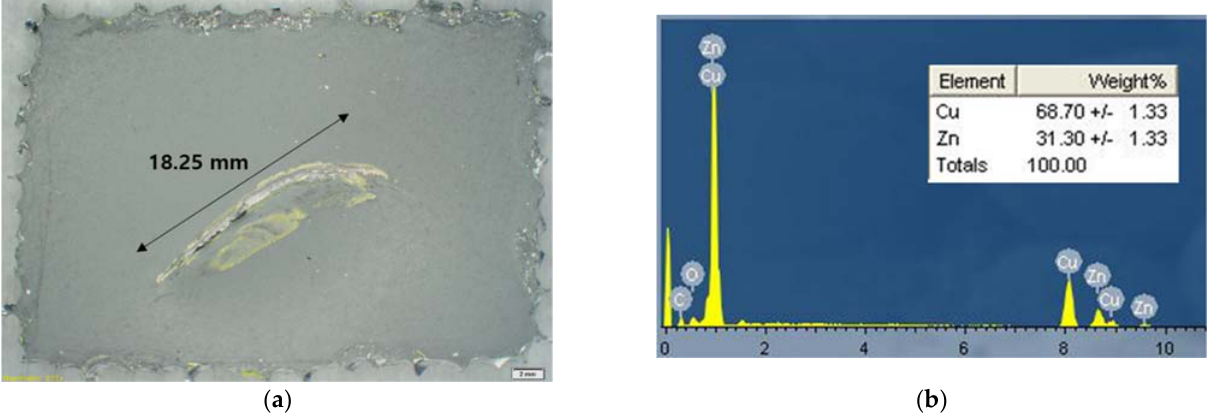
Figure 3. ( a ) Damage on lower nacelle fairing cover and ( b ) chemical composition of damaged sur ‐ face.